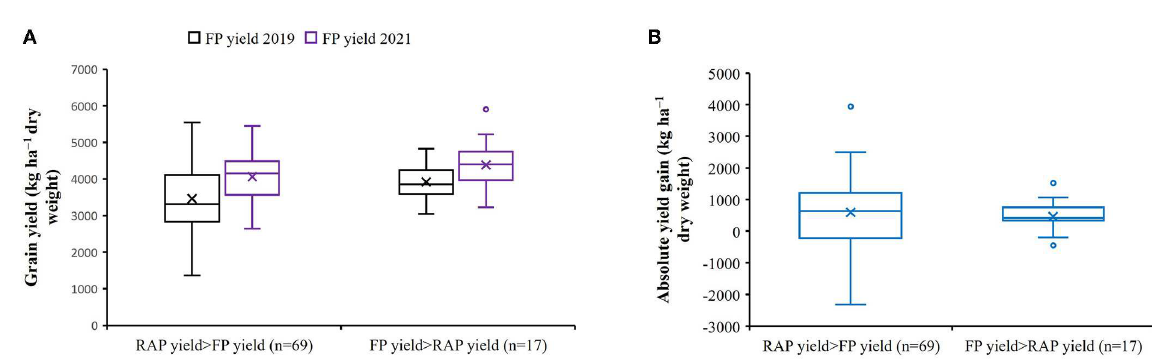
FIGURE4 Distribution of grain yield during (2019) and after (2021) joint experimentation (A) and yield gain of farmers after participation in joint experimentation (B) . Absolute yield gain was calculated as the difference between grain yield under FP (farmer’s practice) after and during